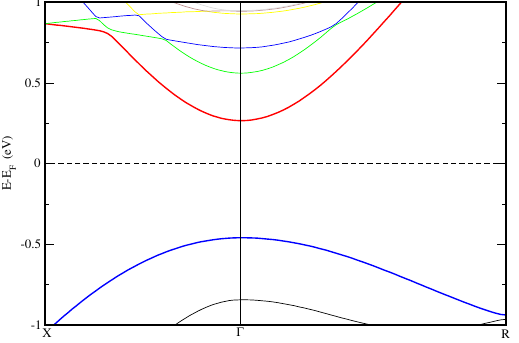
Figure 3. Electronic band structure of STO in TiO 2 termination without MoS 2 . Horizontal dashed line implies the E f set to zero energy at